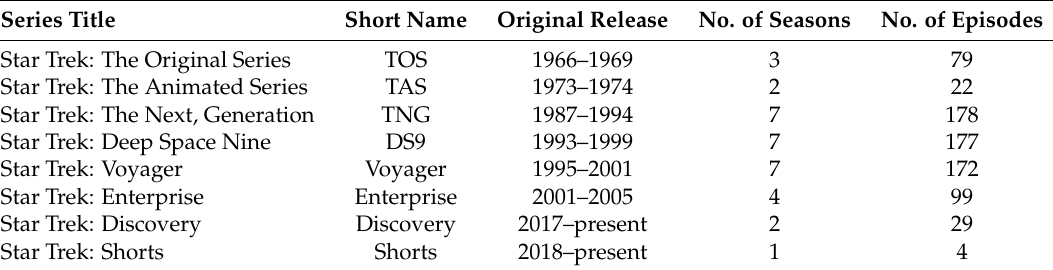
Table 1. The Star Trek television series